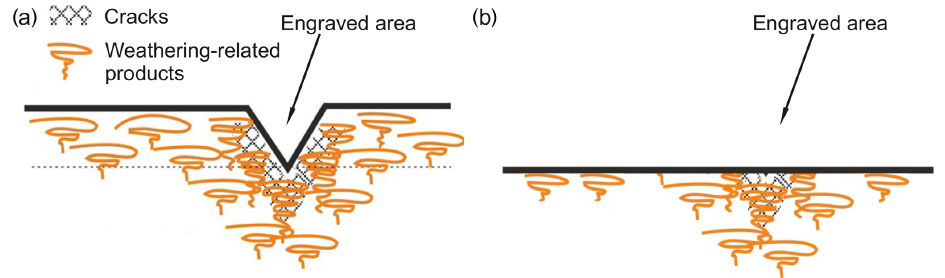
Figure 1. Schematic representations of cross sections of an inscribed object in which the products directly or indirectly induced by weathering processes are more prominent beneath the engraved area than away from it. (a) The inscription is still legible; (b) the surface is deteriorated to the extent in which the inscription is hardly readable or no longer readable. Table 1. Sample designation, provenance, inscription age, mineral grain size, and letter colouring. The mineral-phase composition was determined by XRD and WD-EPMA (mineral abbreviations: Cal: calcite; Qz: quartz; Dol: dolomite; Ap: apatite; Fsp: feldspar; Py: pyrite; Fl: fluorite). Sample Location Inscription Grain size Coloured Mineral inventory age Major Accessory minerals